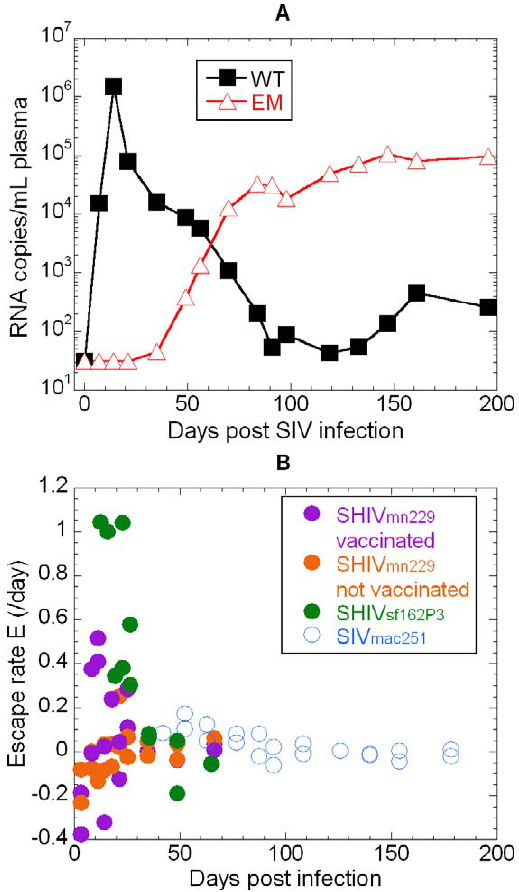
Figure 7. Slow Escape during Chronic SIV Infection and Comparison of Escape Rates across Multiple Viruses (A) KP9 EM and WT viremia was studied in a naı¨ve pigtail macaque (#5175) infected with SIVmac251. (B) The rate of escape over time at the KP9 epitope following infection with three different strains of virus: In SHIV mn229 (orange circles are not vaccinated, purple circles are vaccinated), early reversion is followed by viral escape. In SHIV SF162P3 infection (green circles), escape occurs early and the escape rate is fast. In SIV mac251 infection (open blue circles), escape occurs late and the escape rate is